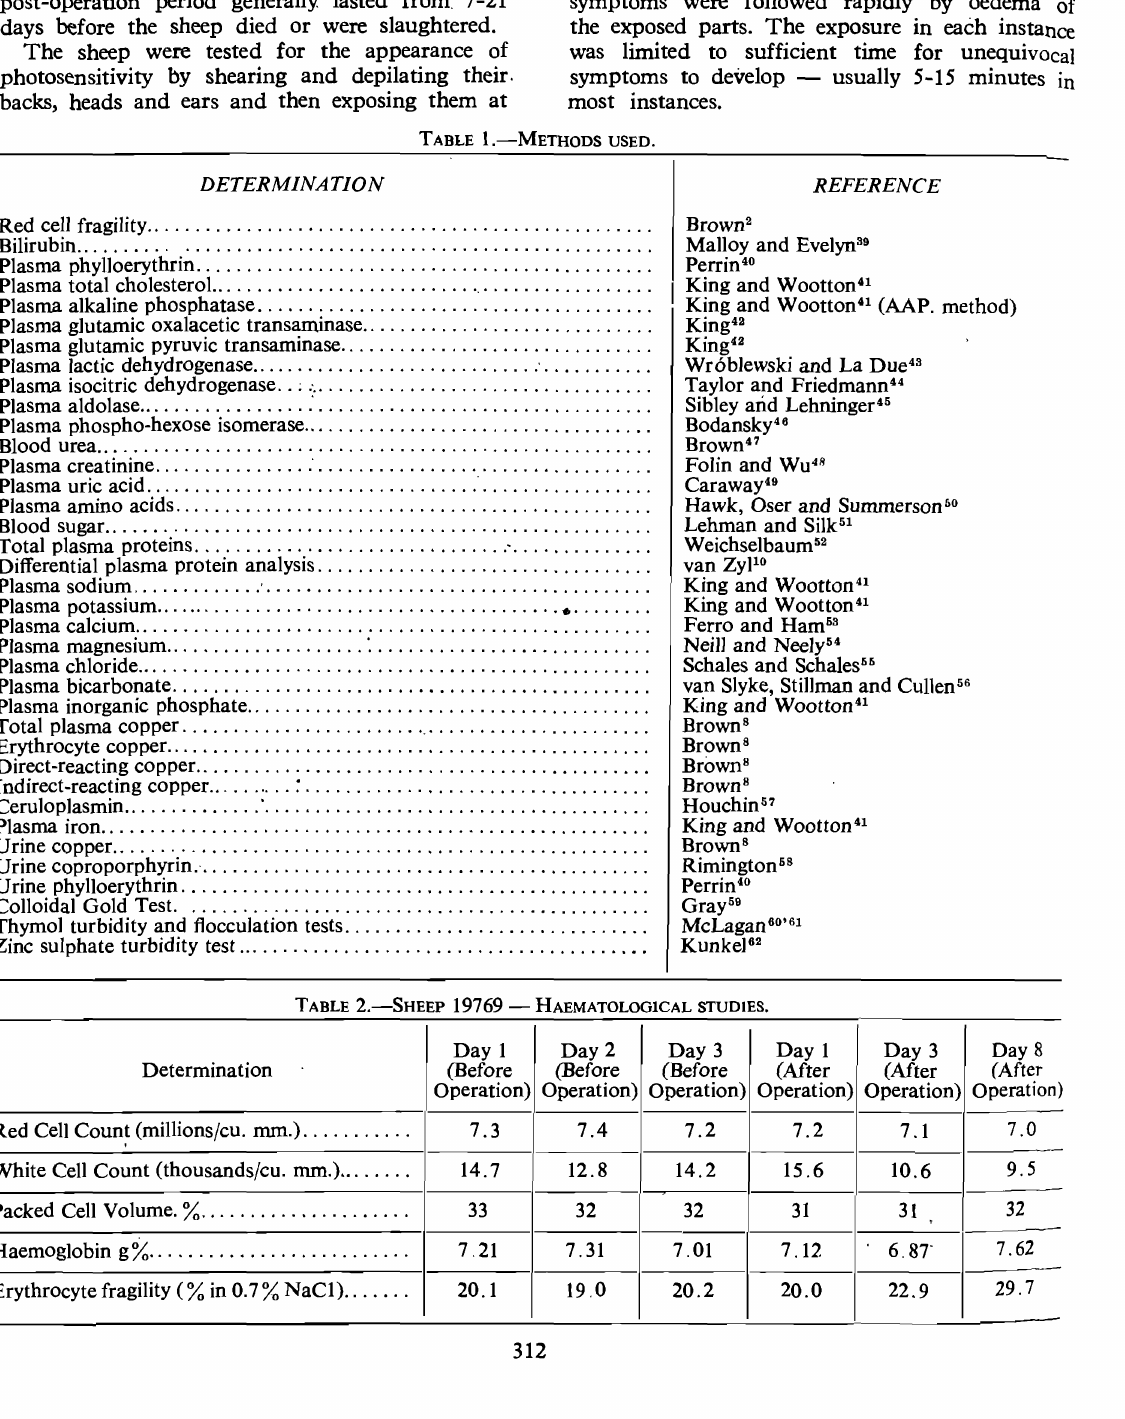
TABLE I.-METHODS USED.